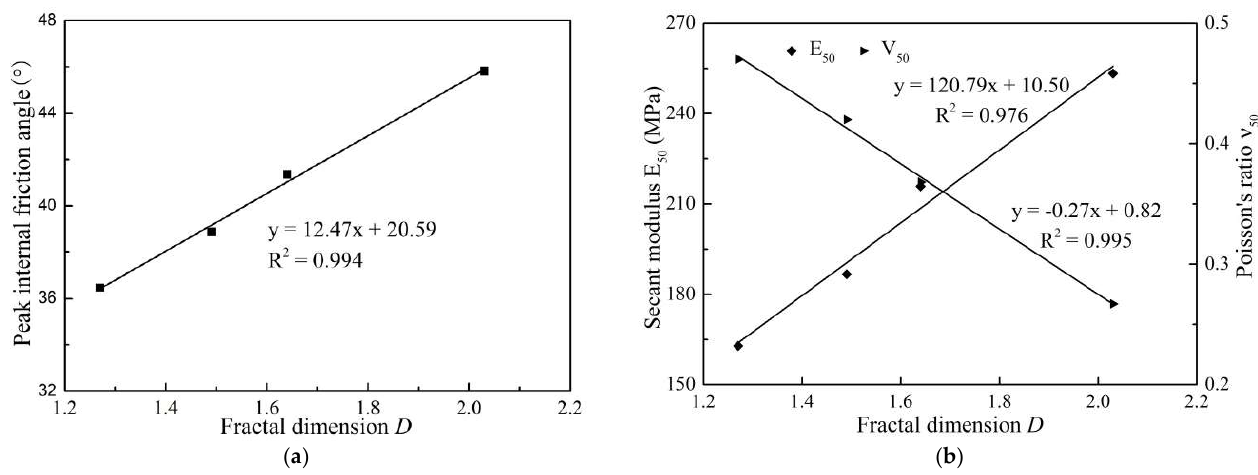
Figure 5. Relationships between index of strength and deformation characteristics with fractal dimension D . ( a ) strength characteristics, ( b ) deformation characteristics.